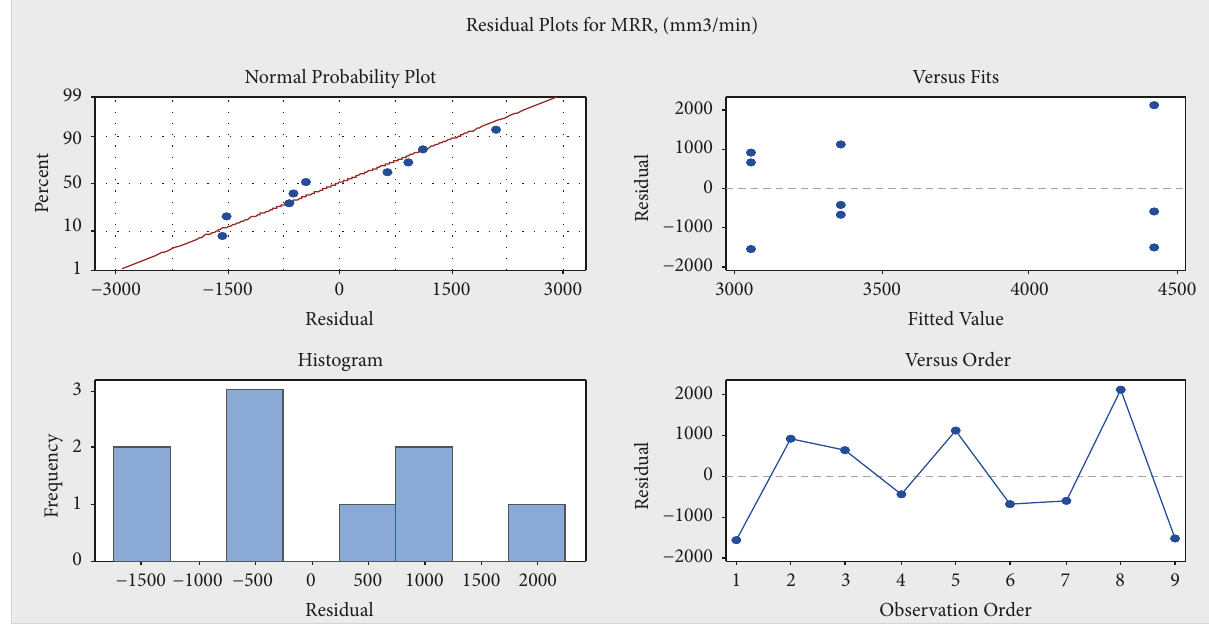
Figure 7: Residual plots for MRR (mm 3 /min) due to the effect of process control